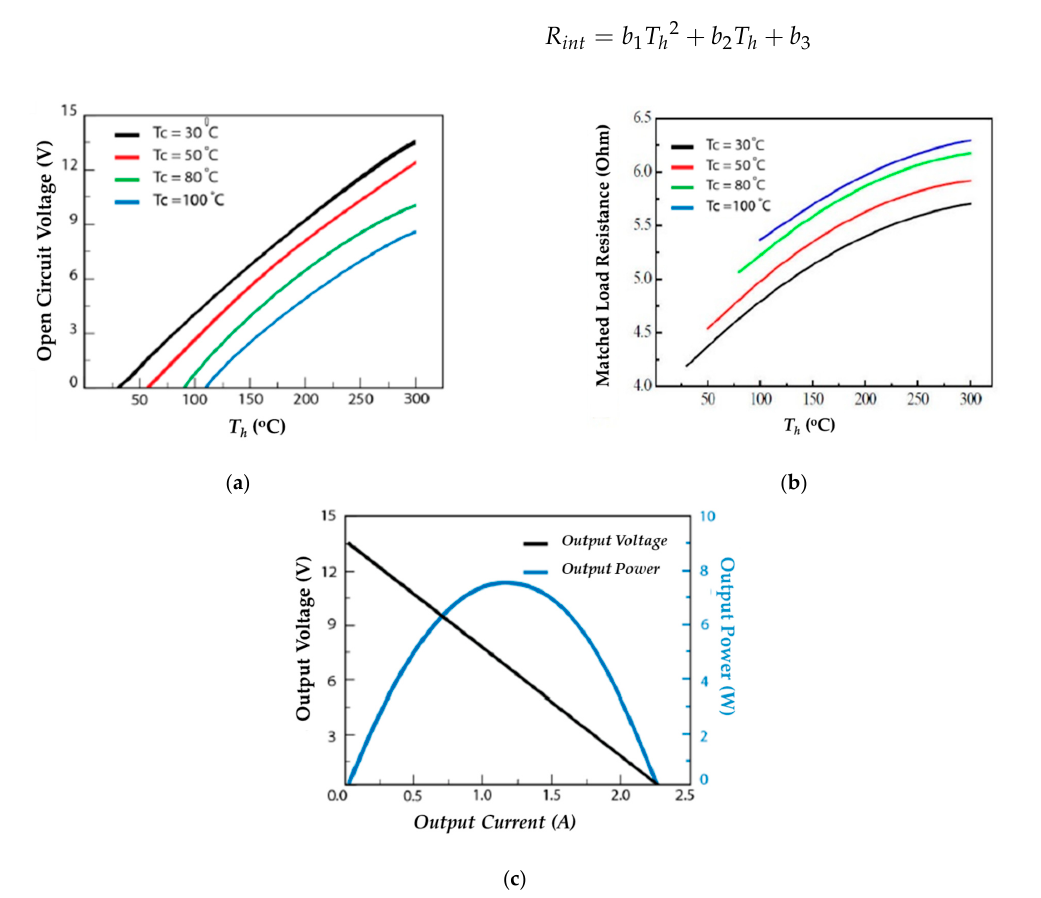
Figure 4. TEM manufacturer datasheet: ( a ) open circuit voltage vs. T h under various T c , ( b ) matched load resistance vs. T h under various T c , and ( c ) output power and output voltage vs. current under T h = 300 °C and T c = 30 °C. Table 1. Polynomial coefficients of V oc and R int .